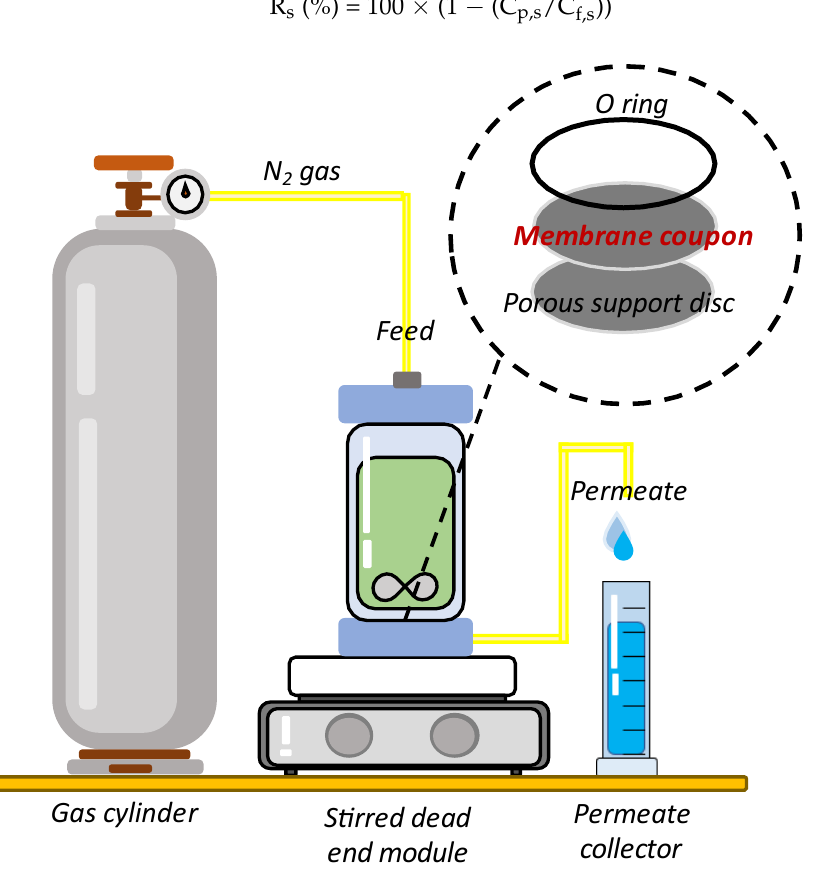
Figure 2. Schematic diagram of dead-end filtration system; the feed flow is forced through the membrane at a given pressure through nitrogen gas.